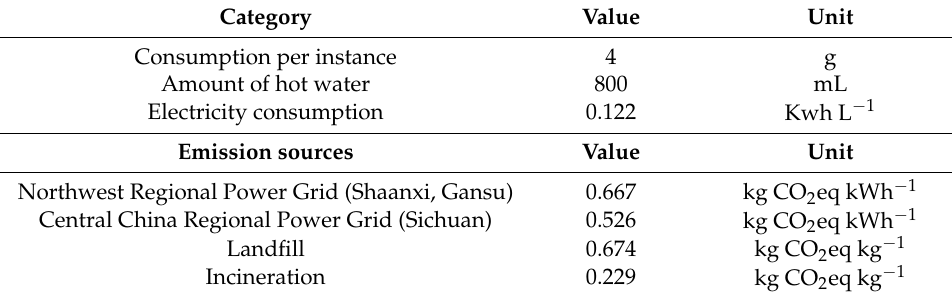
Table 6. Emission inventory of consumption and disposal. Category Value Unit Consumption per instance